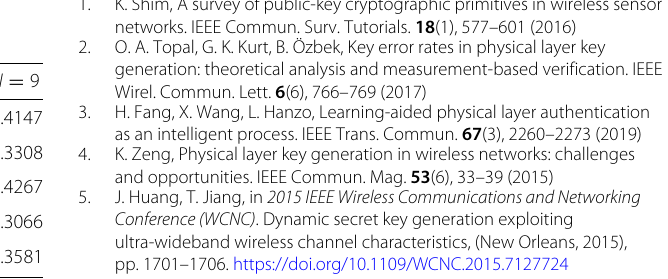
key. The test results for 4 different cases are showed in Table 4. All cases pass the test with p value greater than 0.01, which is used as the evaluation threshold. Therefore, these results prove that the keys generated in our scheme can be used to secure the communications.